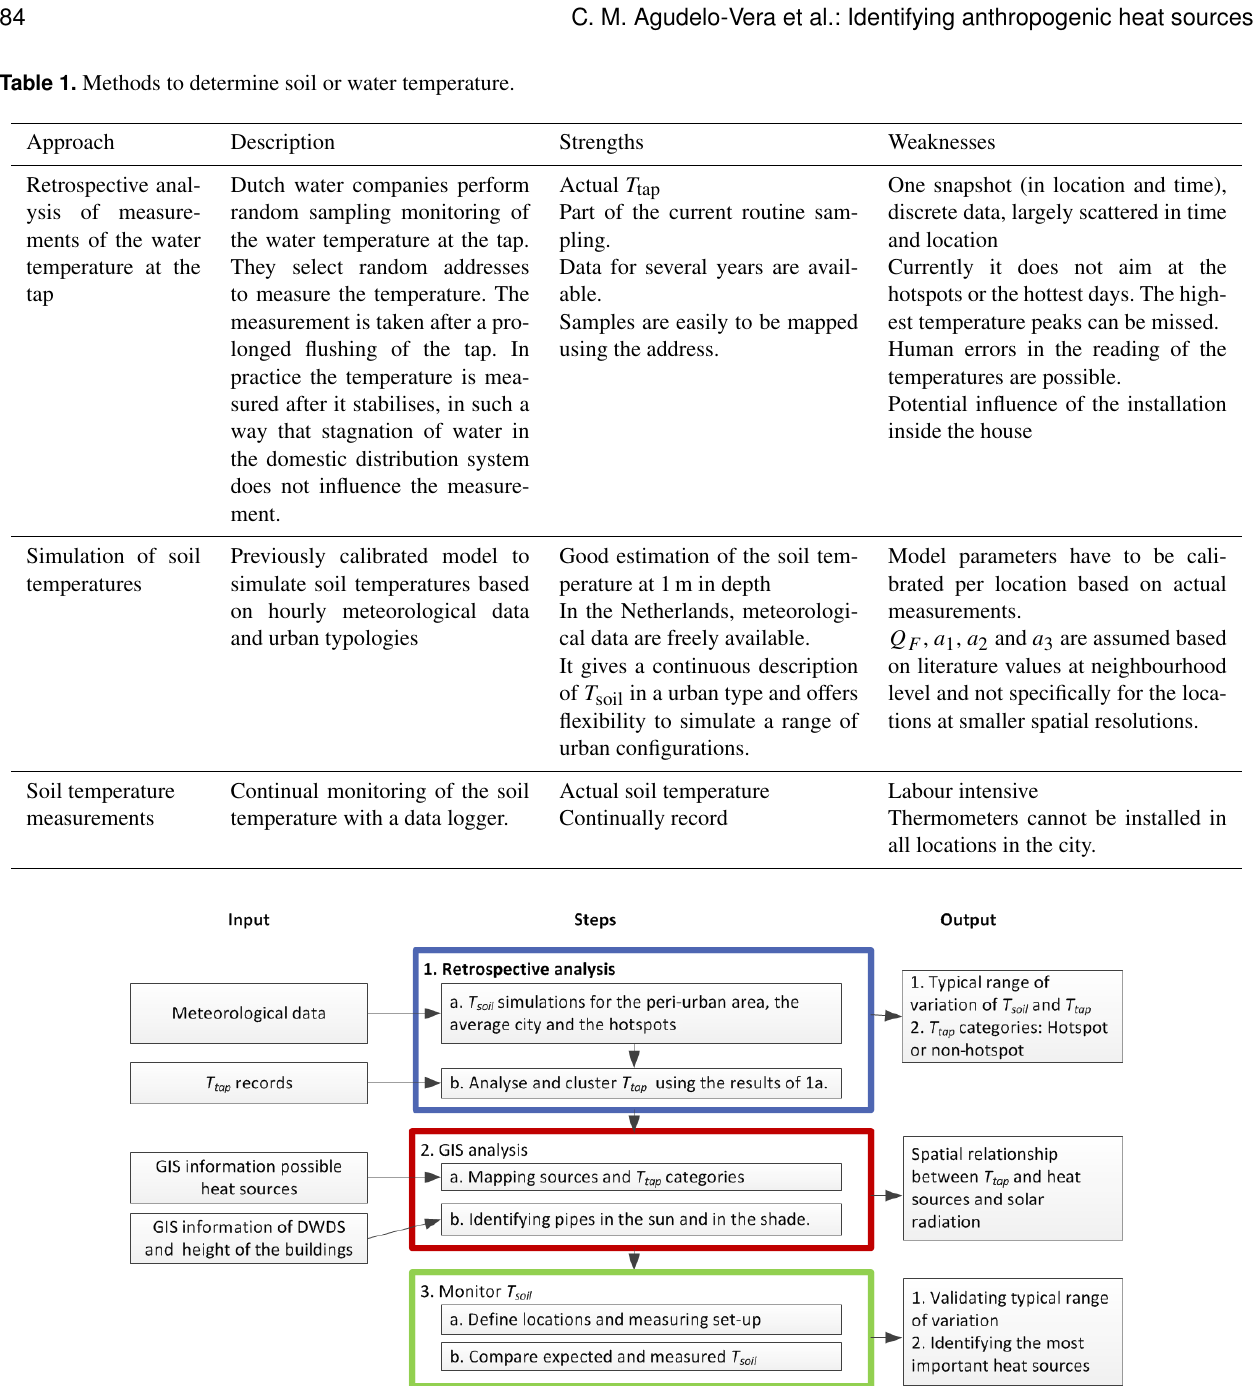
surrounding rural areas due to human activities. UHI typi- cally refers to the air temperature, SUHI to the surface urban heat island and SSUHI to the subsurface urban heat